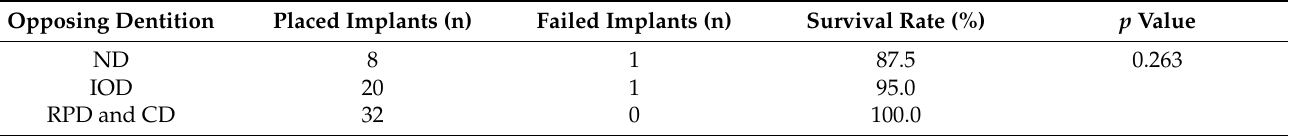
Table 6. Survival rate according to opposing dentition.